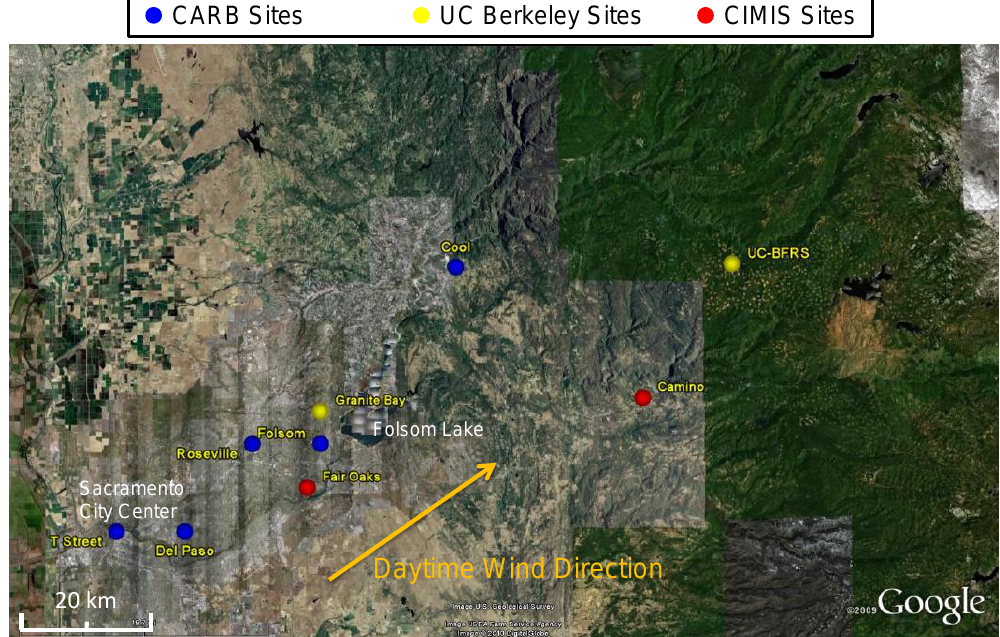
Fig. 1. Map of the Greater Sacramento Area indicating the location of monitoring stations used in this analysis. Yellow circles are UC Berkeley research sites, blue circles are CARB monitoring sites, and red circles are CIMIS weather stations. Map created using Google